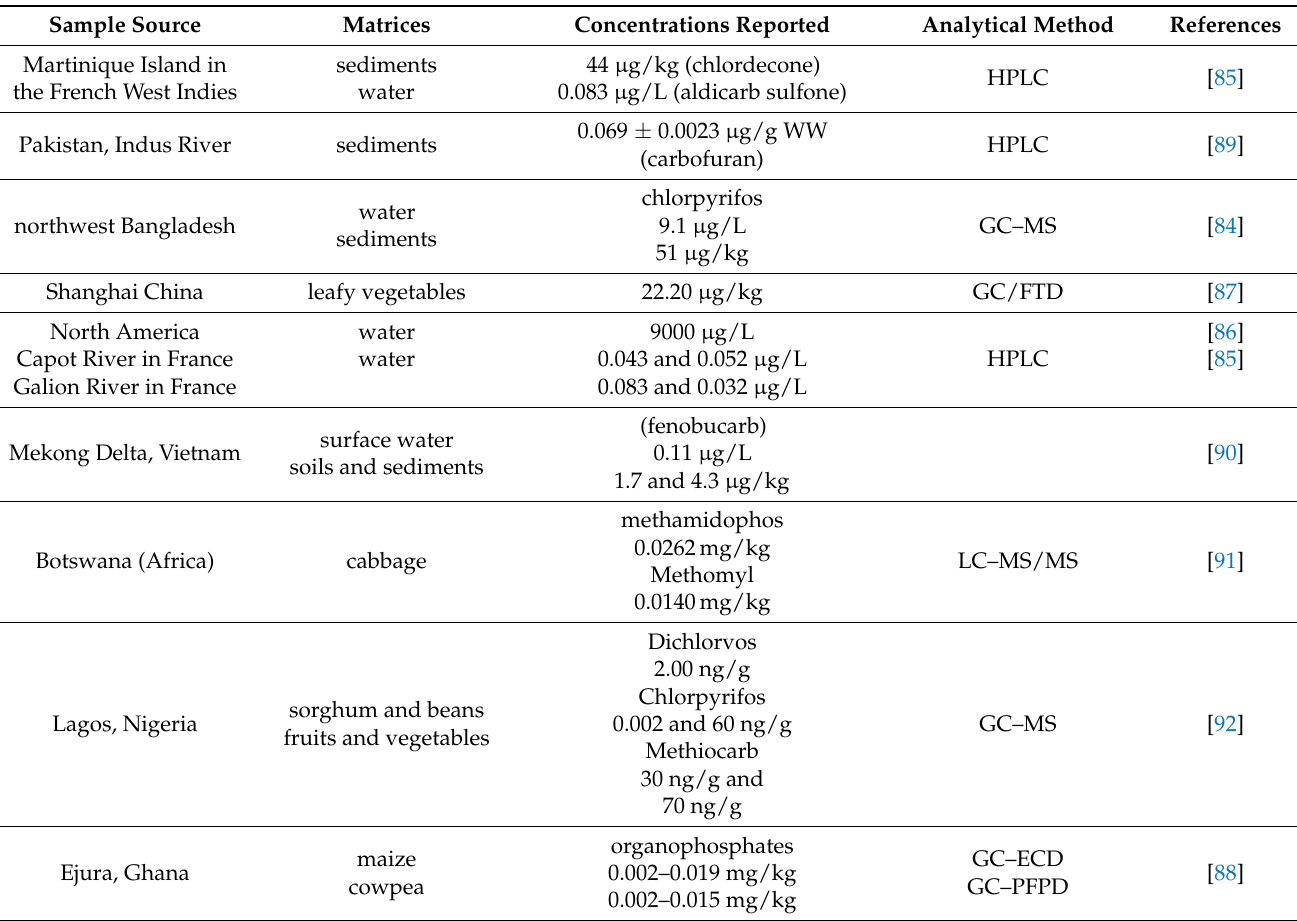
Table 9. Reported concentrations of CM and OP pesticides in different matrices around the